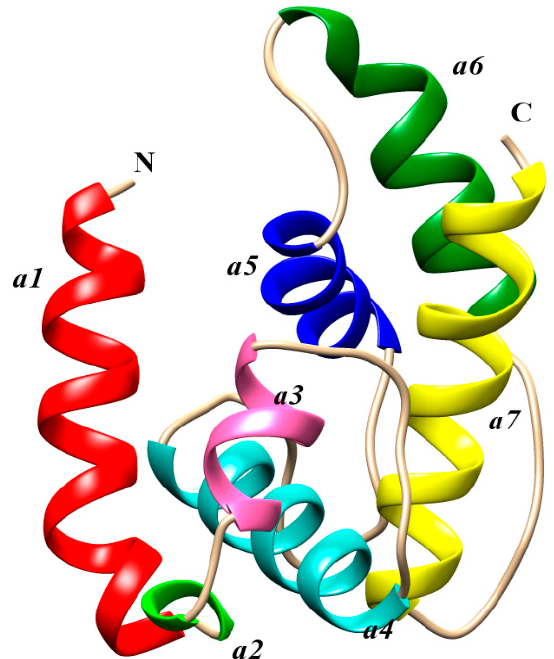
Figure 6. Three-dimensional structure modeling of the SaveOBP9. 3D structure of the SaveOBP9 and dmelOBP28a from Drosophila melanogaster (PDB ID: 6QQ4). Seven alpha-helices are represented in different colors such as N-terminus, α 1:red, α 2:green, α 3:pink, α 4: sea green, α 5:blue, α 6: dark green, α 7: yellow and C-terminus.